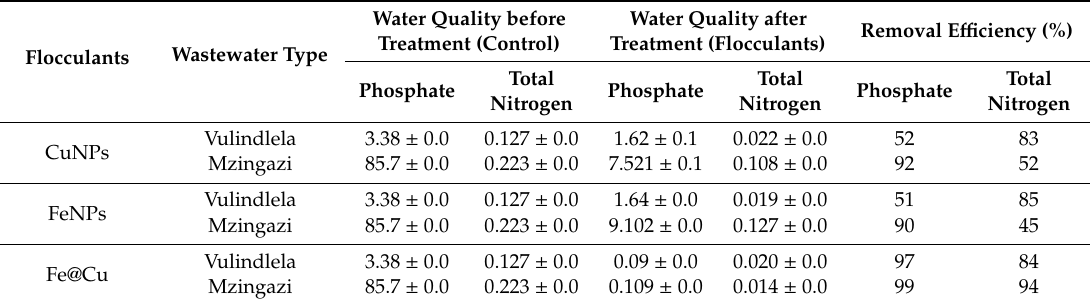
Table 2. Phosphate and total nitrogen removal in wastewater by nanoparticles under room temperature.